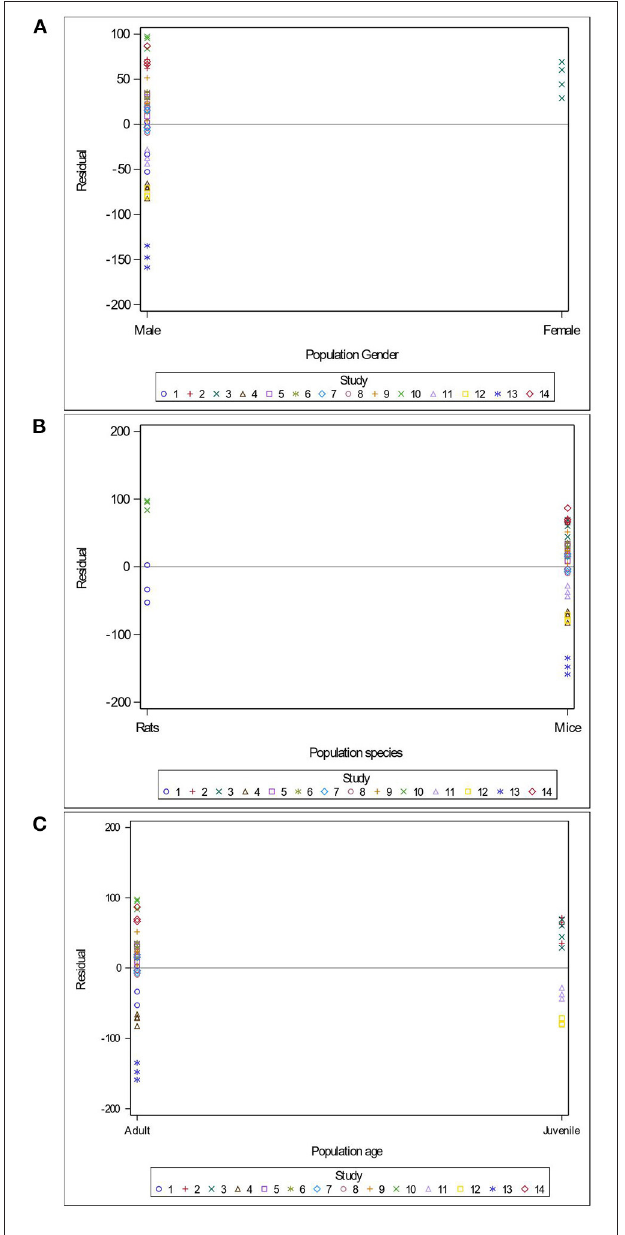
FIGURE 4 | Raw residuals of Model 3 (Supplementation*Stress) plotted against the sex (A) , species (B) and age (C) of the population, where points represent treatment means and are coded by study.